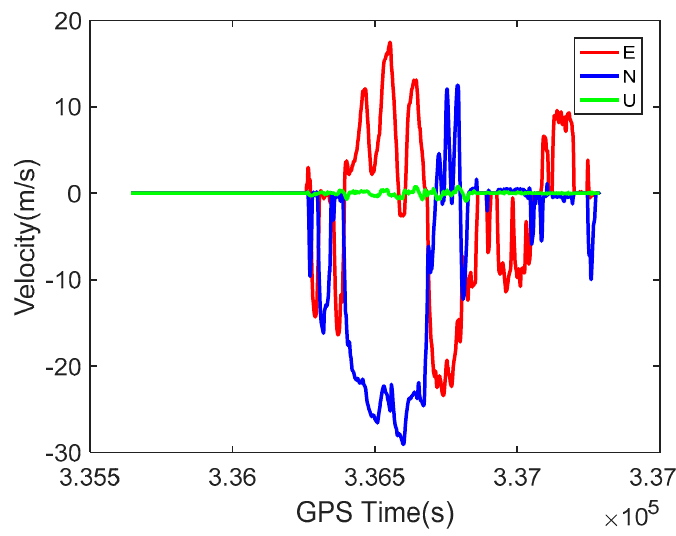
Figure 10. The velocity of the reference trajectory.